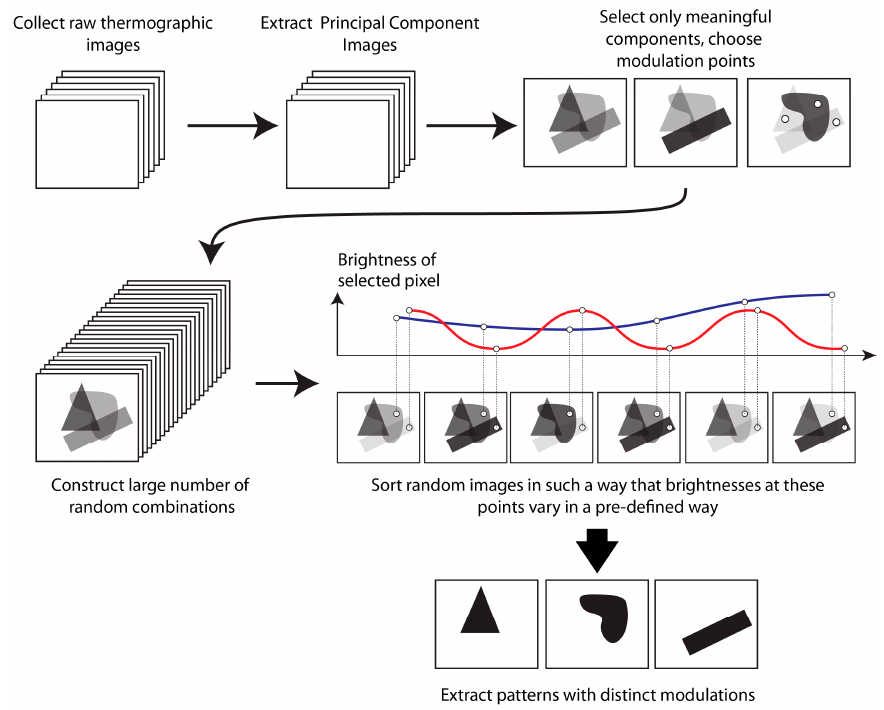
Figure 6. Explanation of the algorithm. The red and blue graphs schematically indicate how brightnesses of two particular pixels change through the stack of the sorted images.